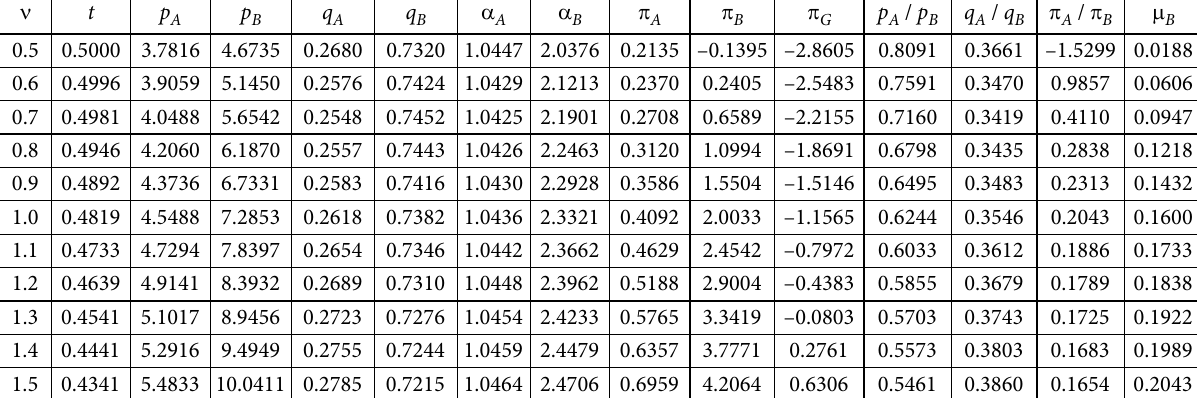
Table 2. Dynamic changes of all the factors caused by changes in consumer preference n